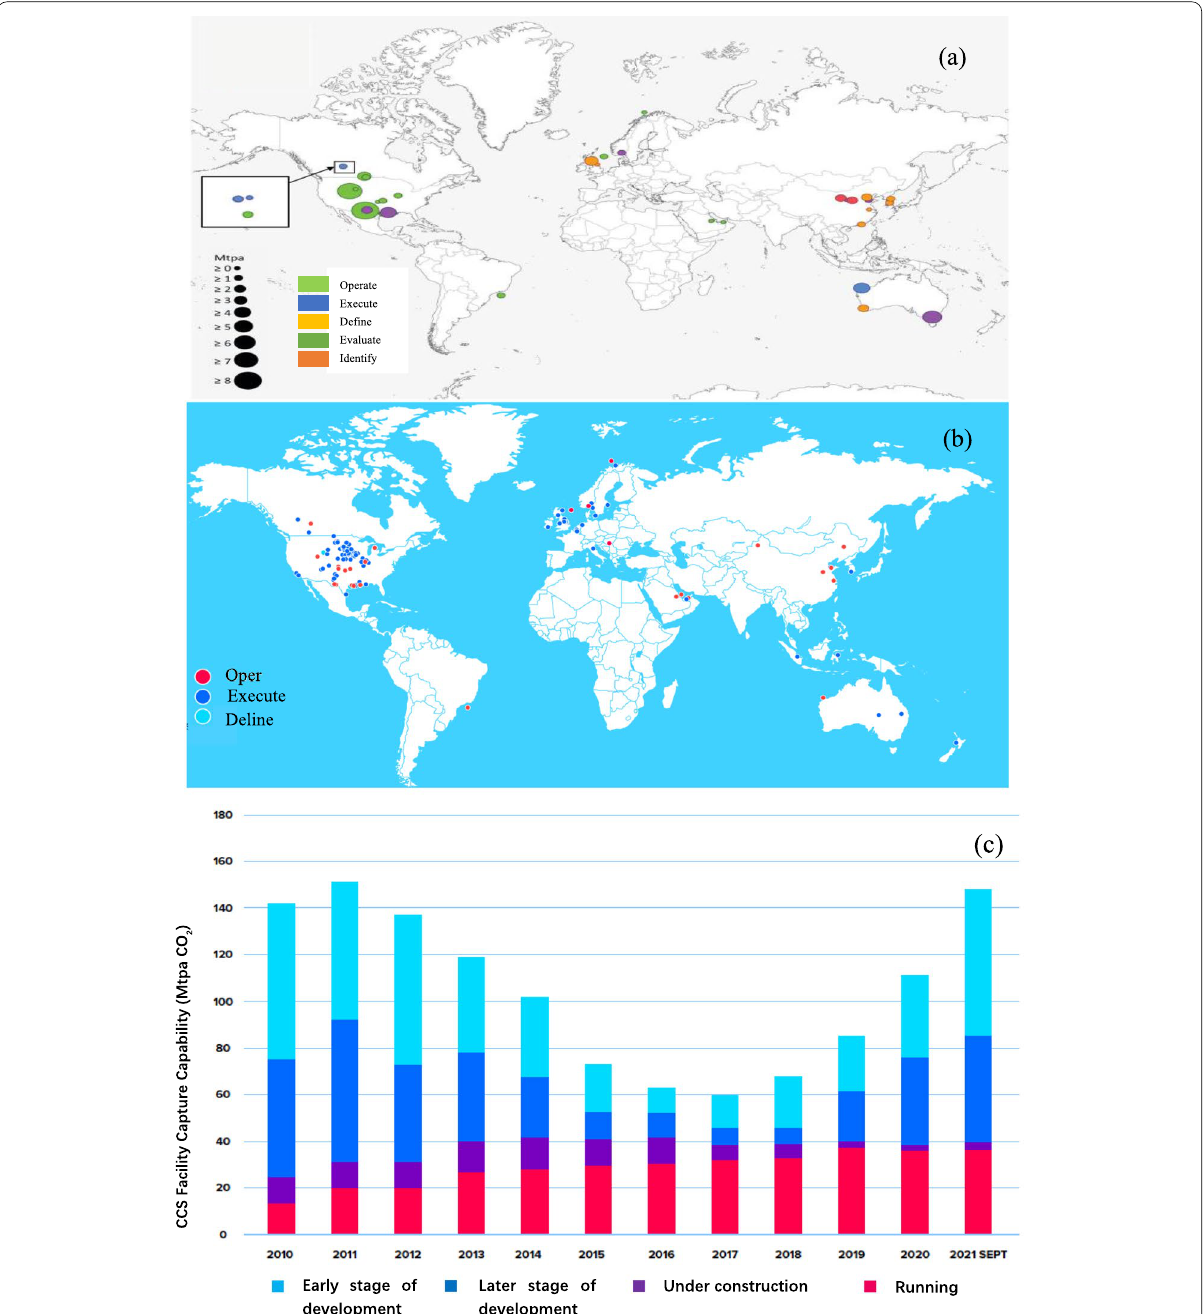
Fig. 3 Scale of global commercial CCS development: ( a ) 2016 [30]; ( b ) 2021 [31]; ( c ) 2010–2021 Commercial CCS Facilities Plan [31]. Data from the Global CCS